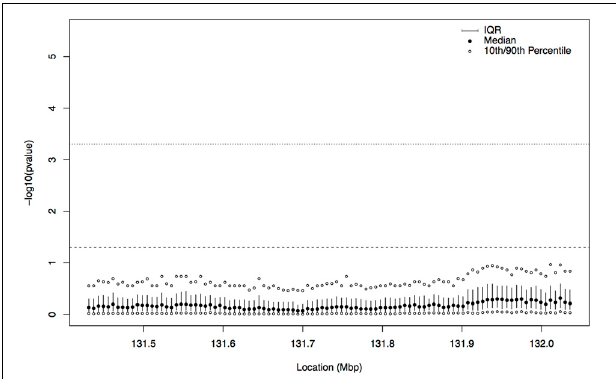
FIGURE 6 | Plot summarizing the distribution of the latent p -values by focal point for the permuted case-control labels on haplotypes. The interquartile range (IQR) at each focal point is indicated by the solid vertical line, the filled in circle is the median, and the open circles represent the 10th and 90th percentiles of the distribution of − log 10 of the latent p -values. The dashed horizontal line indicates a p -value cutoff of 0.05 and the dotted horizontal line shows a p -value cutoff of 0.0005 (Bonferroni corrected for 100 focal points). For all focal points, the 90th percentile of the distribution of − log 10 of the latent p -values is below the 0.05